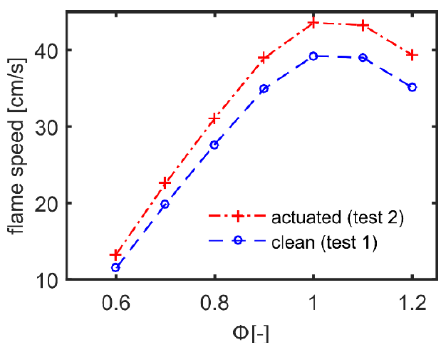
Figure 10. Axial profiles of temperature predicted by PFR computations.